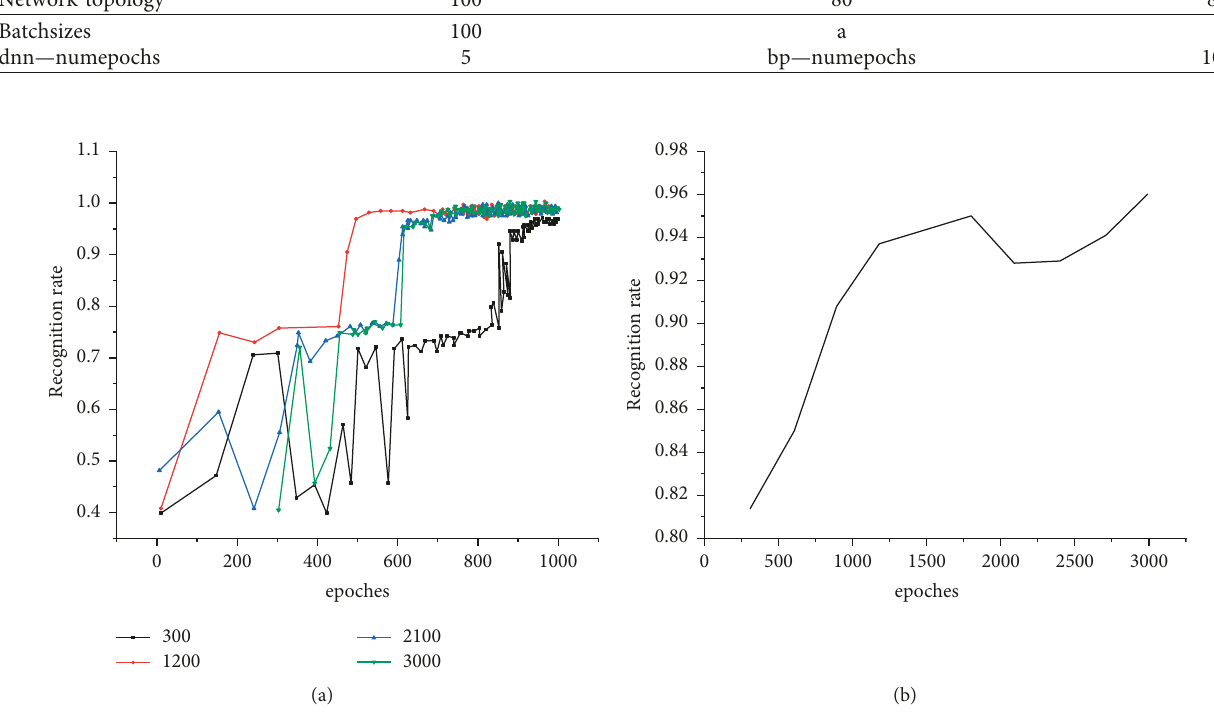
Figure 2: Changes in the recognition rate under changes in the number of